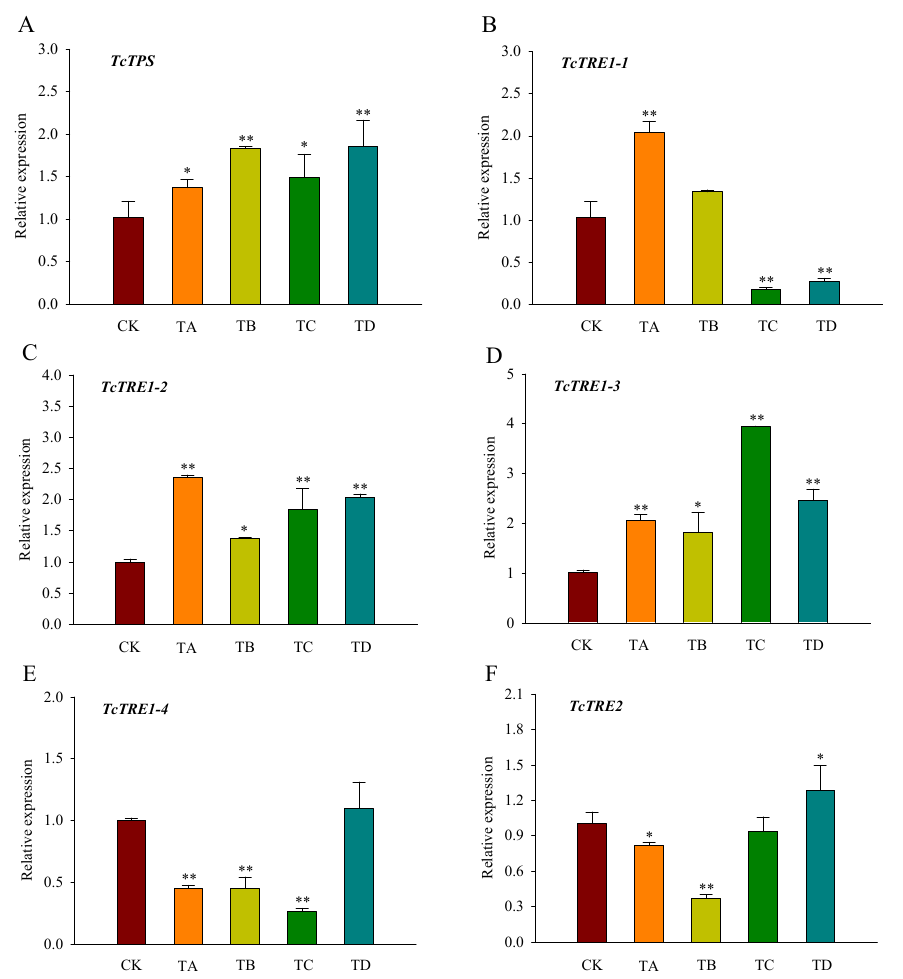
Figure 5. Relative expression levels of key genes in the trehalose metabolic pathway (( A ) TcTPS ; ( B ) TcTRE1 ‐ 1 ; ( C ) TcTRE1 ‐ 2 ; ( D ) TcTRE1 ‐ 3 ; ( E ) TcTRE1 ‐ 4 ; ( F ) TcTRE2 ) in T. castaneum treated with different concentrations of carbon dioxide for 48 h, represented by CK, TA, TB, TC, and TD. CK, treated with air for 48 h; TA, treated with 25% CO 2 + 75% air for 48 h; TB, treated with 50% CO 2 + 50% air for 48 h; TC, treated with 75% CO 2 + 25% air for 48 h; TD, treated with 95% CO 2 + 5% air for 48 h. TPS , trehalose ‐ 6 ‐ phosphate synthase; TRE1 , soluble trehalase, including TRE1 ‐ 1 , TRE1 ‐ 2 , TRE1 ‐ 3 and TRE1 ‐ 4 ; TRE2 , membrane ‐ bound trehalases. * p < 0.05, ** p < 0.01, according to Student’s t ‐ test.